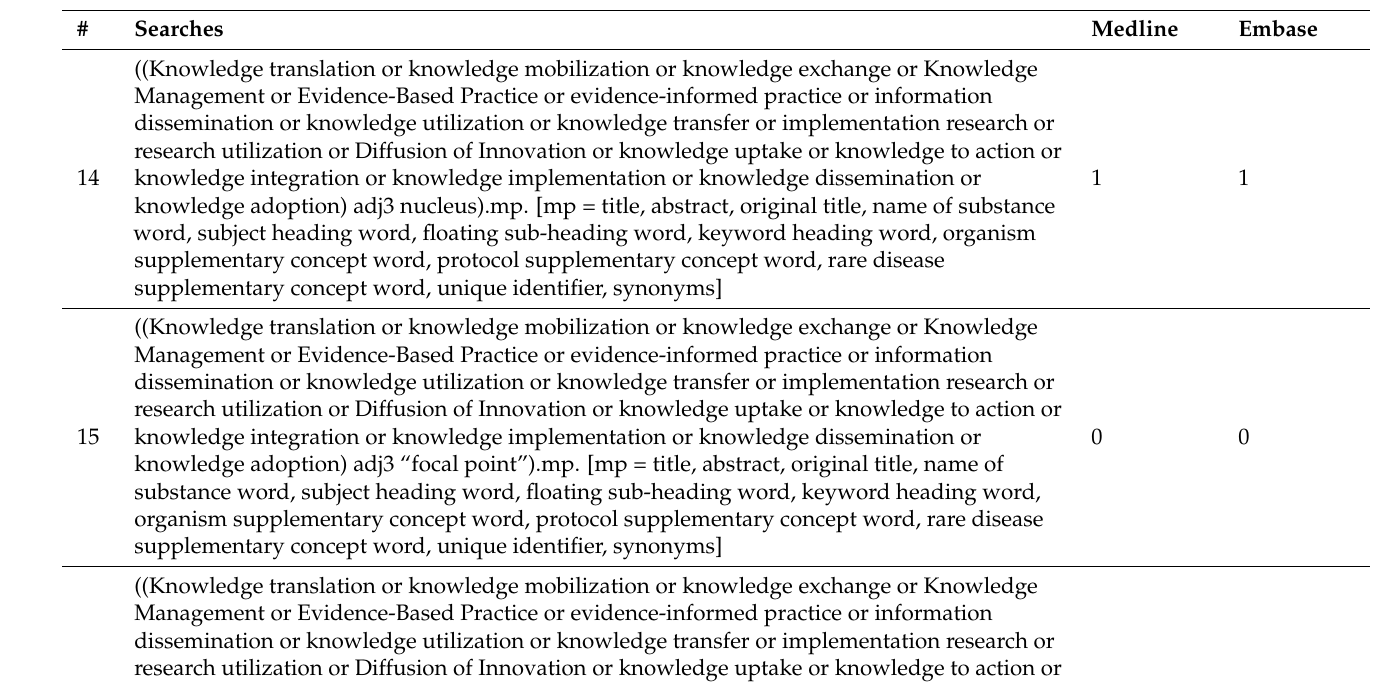
substance word, subject heading word, floating sub-heading word, keyword heading word, organism supplementary concept word, protocol supplementary concept word, rare disease supplementary concept word, unique identifier, synonyms]